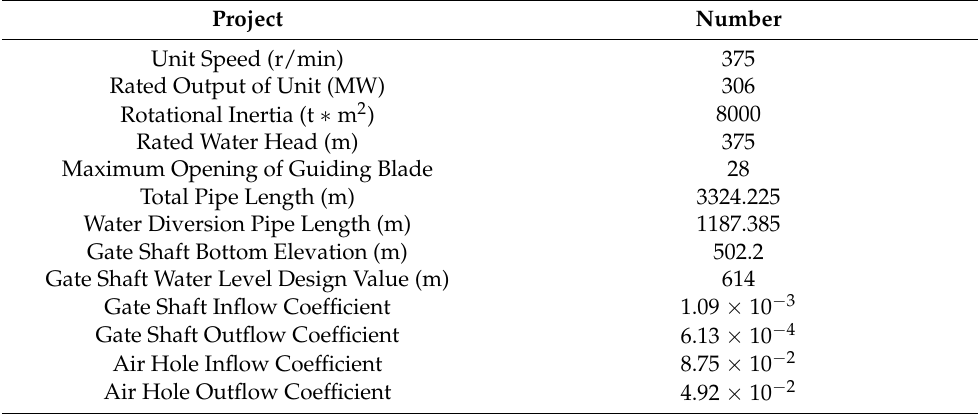
Figure 3. Diagram of A power station. Table 1. A power station parameters.